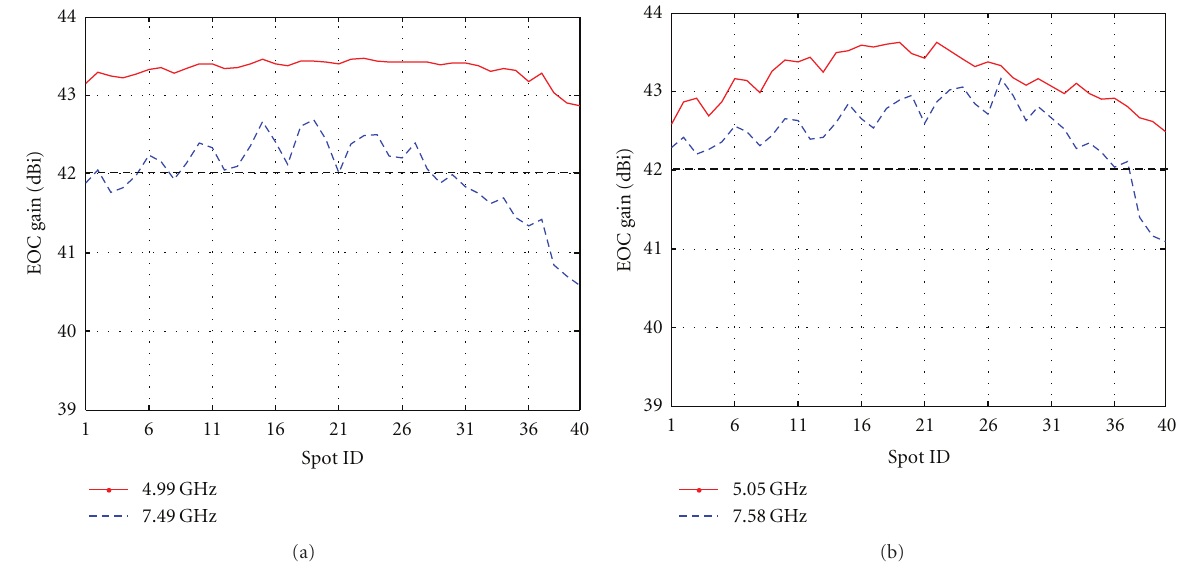
Figure 26: EOC gain on the coverage at channel 1 (a) and channel 2